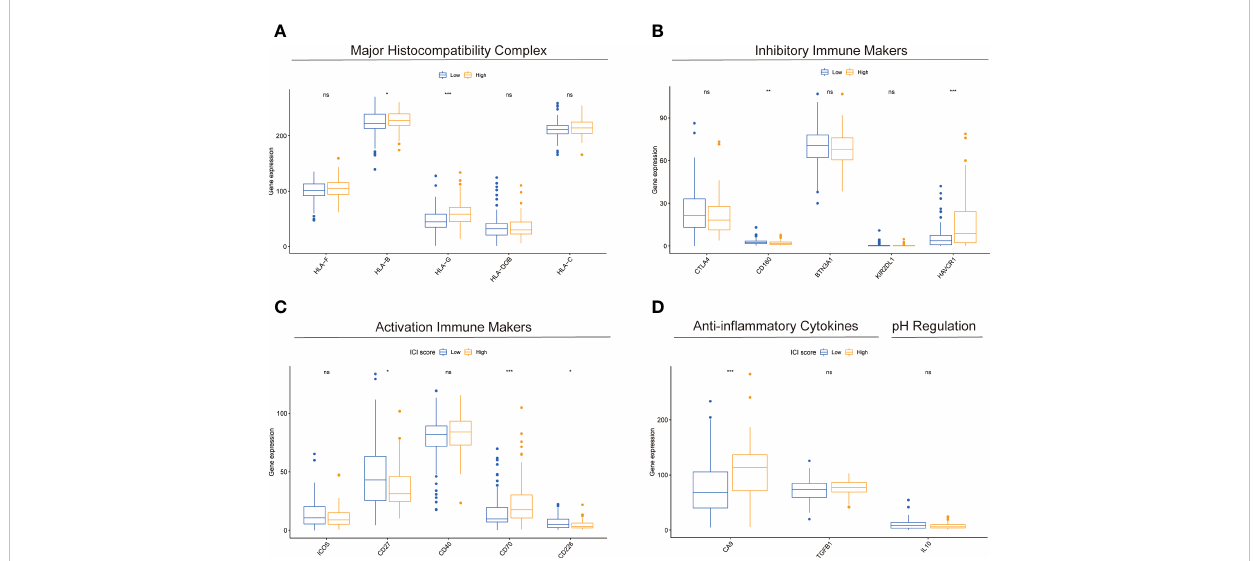
FIGURE 8 Comparison of immune-related markers between subgroups based on HAPM. (A – D) The differences in the expression of genes related to Major Histocompatibility Complex, Inhibitory Immune Makers, Activation Immune Makers, Anti-in fl ammatory Cytokines, and pH Regulation in different subgroups of patients, respectively.